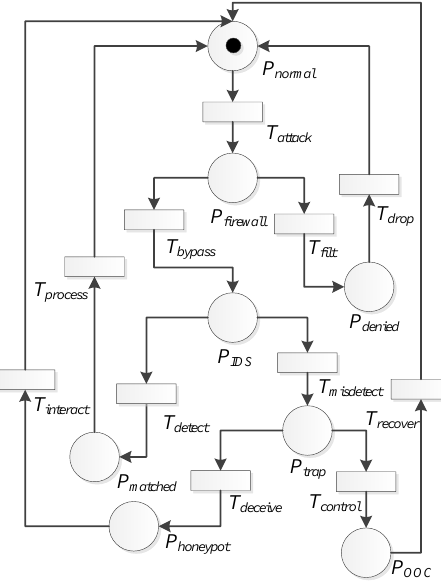
Figure 11. Defense Scenario III: the SPN model.